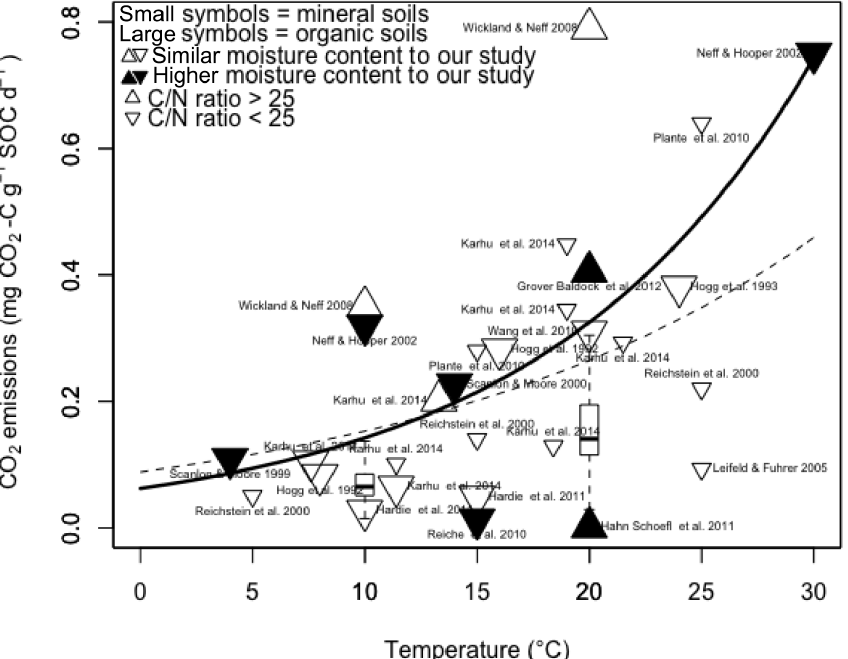
Figure 4. Comparison of daily CO 2 emission rates from this study (box plots) with rates found during other incubation studies (organic soils and mineral soils). The curves represent the modelled CO 2 emission rates for organic soils from other studies (solid thick line) rate = 0.06 × 10 0 . 08 t and mineral soils (dashed thin line) rate = 0.09 × 10 0 . 05 t for temperatures between 0 and 30 ◦